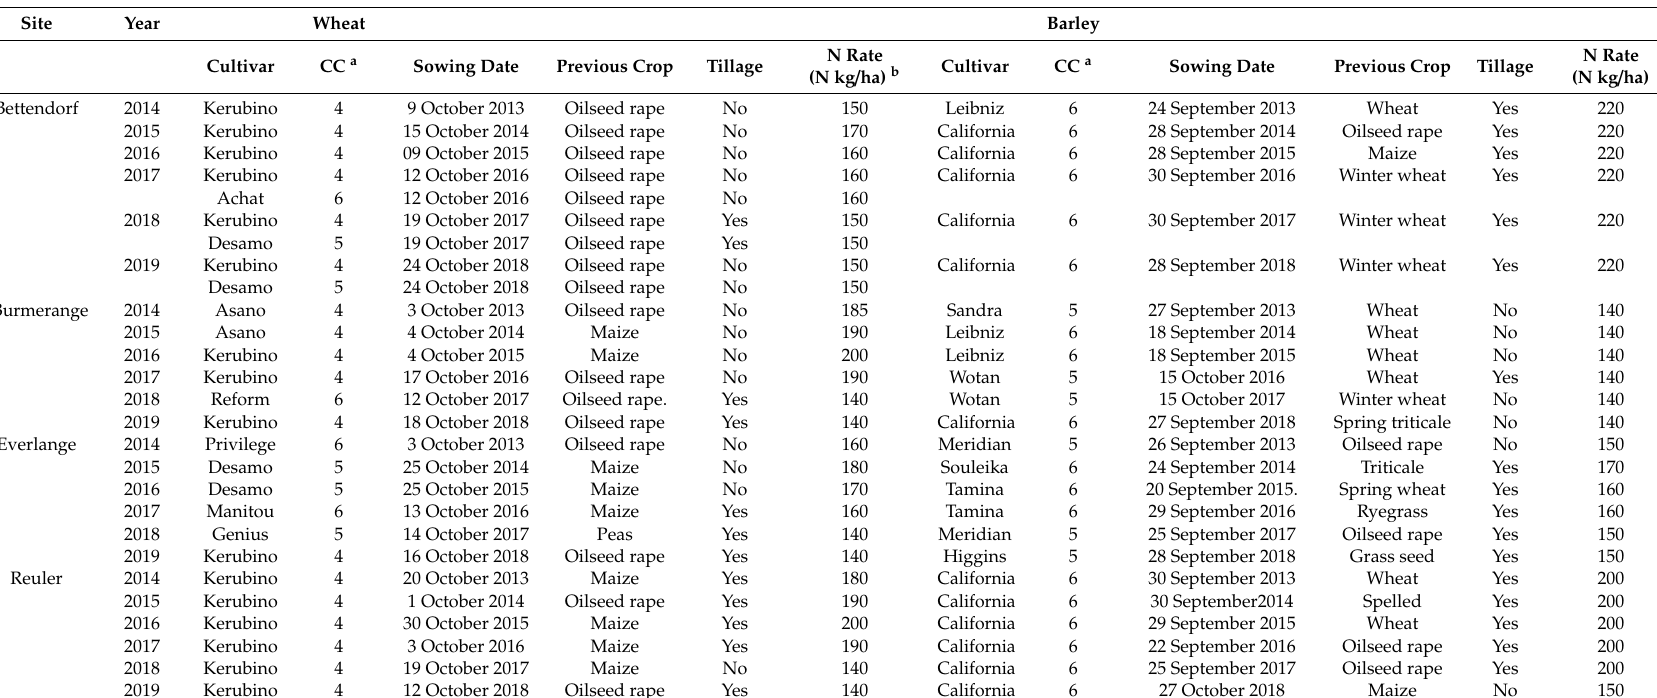
Table 1. Agronomic information for the commercial winter wheat and winter barley fields at the study sites used for investigating the e ff ect of phyllotherm on leaf emergence during the 2014–2019 cropping seasons in the Grand-Duchy of